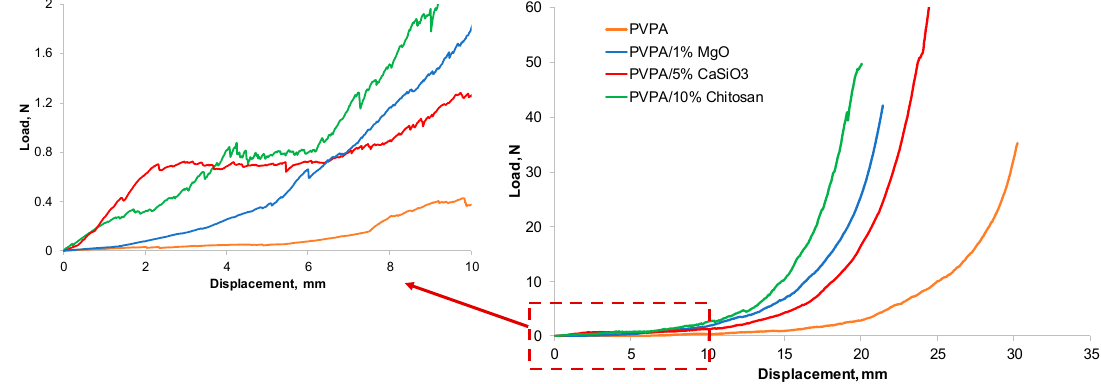
Figure 14. Load/displacement plots for chars from various PVPA based coatings. Figure 14. Load / displacement plots for chars from various PVPA based coatings.